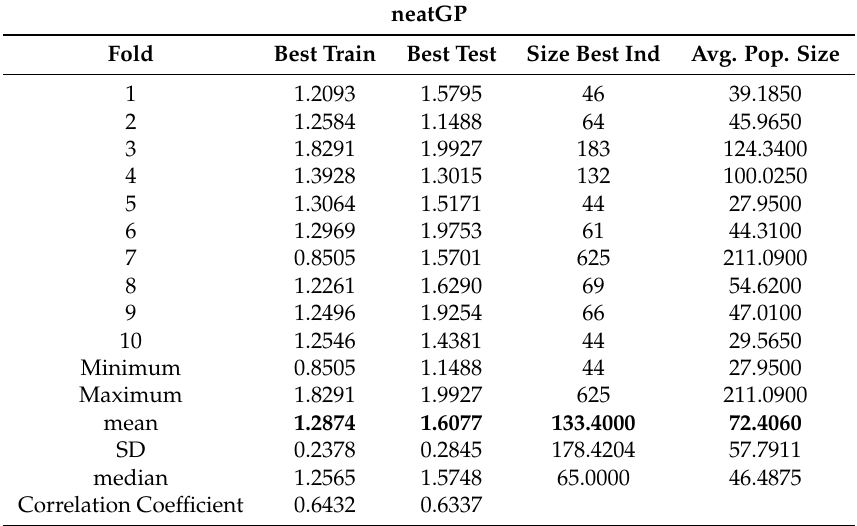
Table 4. RMSE for the 10-fold cross validation performance of neatGP on the 1–10 scale dataset.